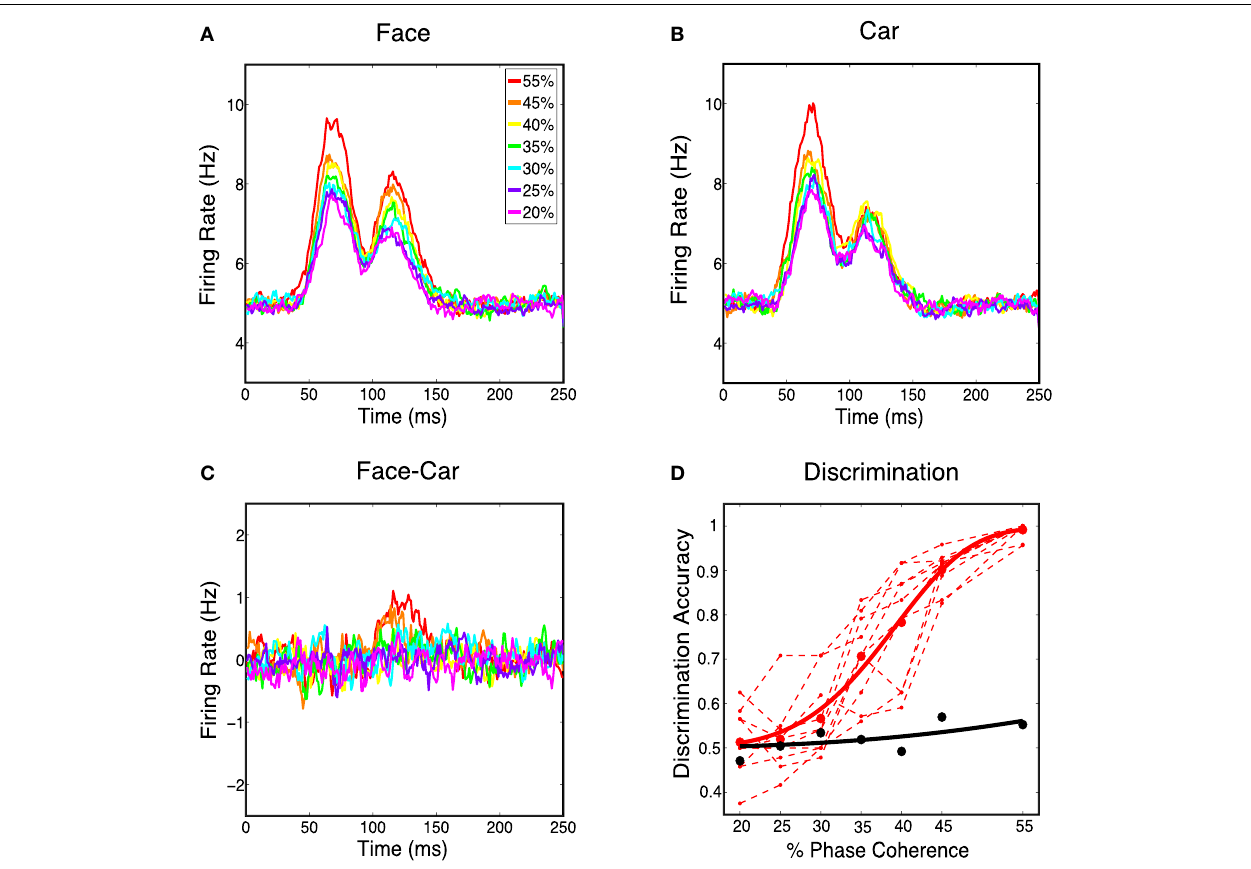
firing rates for theV1 model (thick black curve) is plotted, together with the group average psychometric curve fitted across 10 subjects (thick red curve), and psychophysical performance of 10 individual subjects (thin dashed red